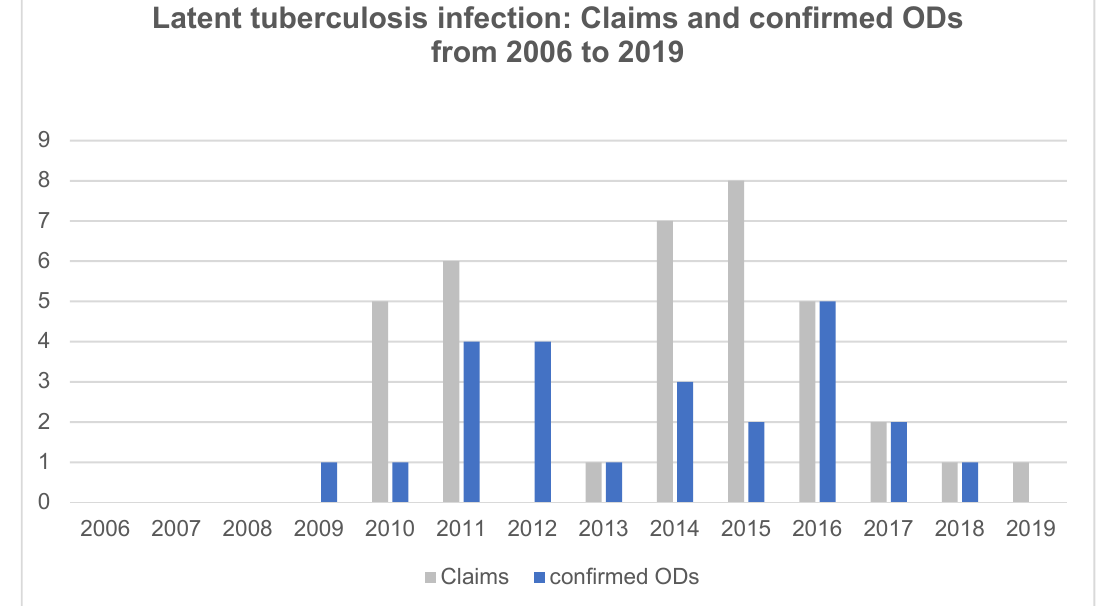
Figure 5. Latent tuberculosis infection: Number of claims and confirmed occupational diseases (ODs) among dental health workers from 2006 to 2019. Table 4. Number of claims and confirmed occupational COVID-19 infections among dental health workers from March 2020 to February 2021. OD = Occupational